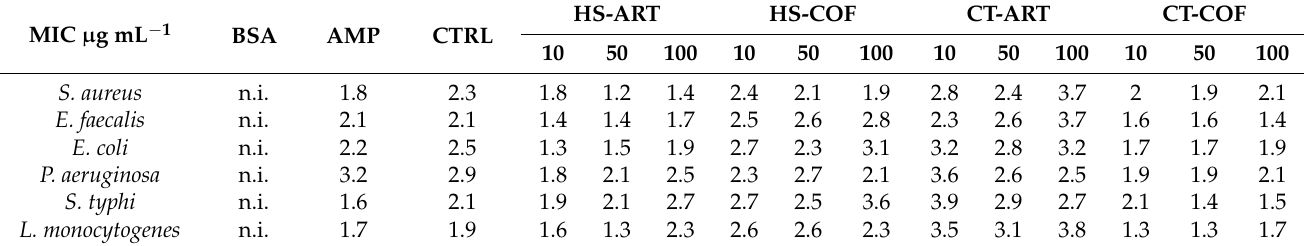
Table 3. Minimal inhibition concentration (MIC) values ( µ g mL − 1 ) of methanolic extracts from basil plants treated with humic substances or compost teas from artichoke or coffee grounds residues (HS-ART; HS-COF; CT-ART; CT-COF) at three different concentrations (10, 50, 100 mg L − 1 ) against S. aureus , E. faecalis , E. coli , P. aeruginosa , S. typhi and L. monocytogenes . The coefficients of variation were invariably smaller than 6%. HS-ART HS-COF CT-ART CT-COF MIC µ g mL − 1 BSA AMP CTRL 10 50 100 10 50